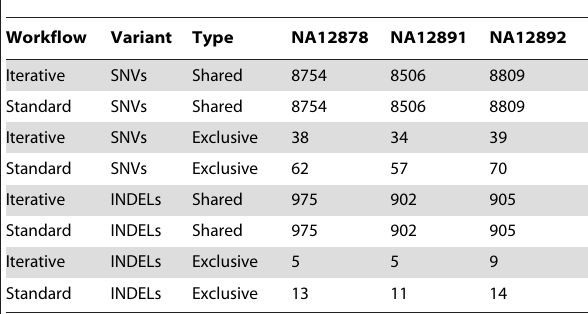
Table 2. Evaluation of SNVs and Indels called by the iterative and standard